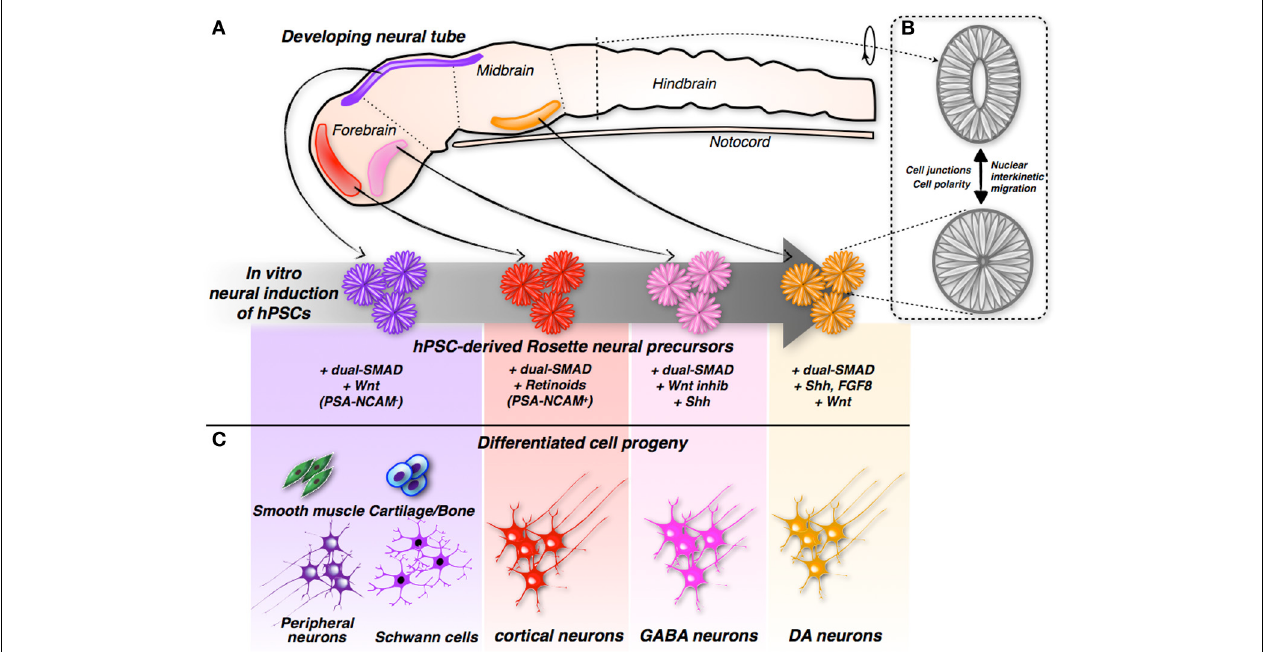
FIGURE 1 | Induction and differentiation of iPSC-derived rosette neural progenitors. (A) Modulation of neurodevelopmental molecular pathways by different combinations of small molecules can direct hPSCs into rosette neural progenitors with different positional identities along the developing neural tube. (B) ThehPSCs-derivedrosetteandtheneuraltubesharethesamespatial